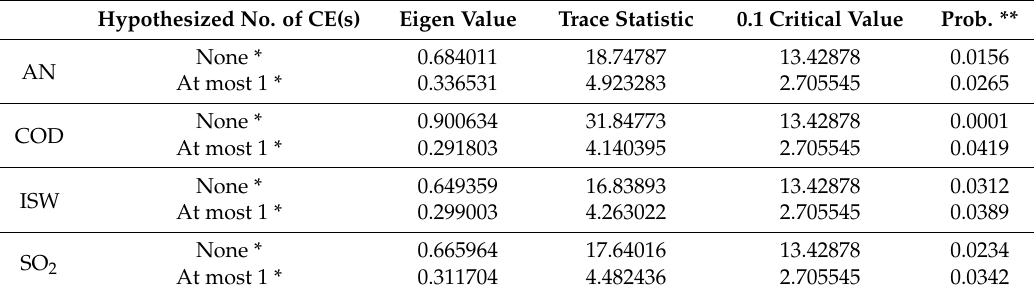
Table 9. Johansen co-integration test for non-ferrous metal ore mining and